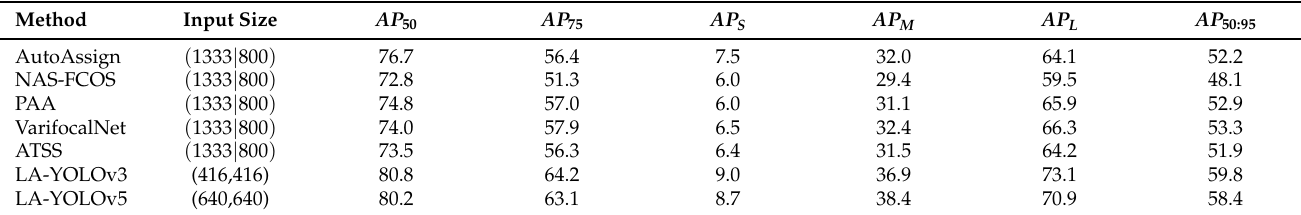
Table 8. The detection performance of different detectors on the DIOR